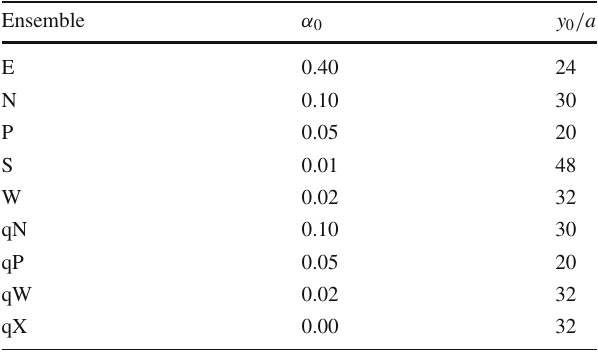
. Distance preconditioning is not i